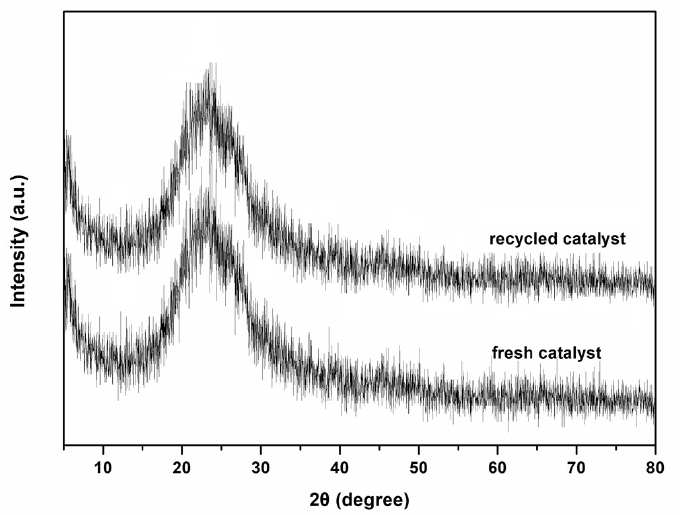
Figure 7. XRD patterns of catalyst MCM-41@ILLaCl 4 before and after reaction.